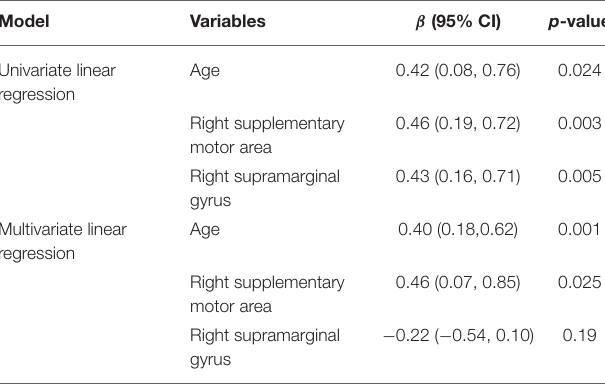
TABLE 2 | Linear regression of the association between regional CBF and depression score in AD. Model